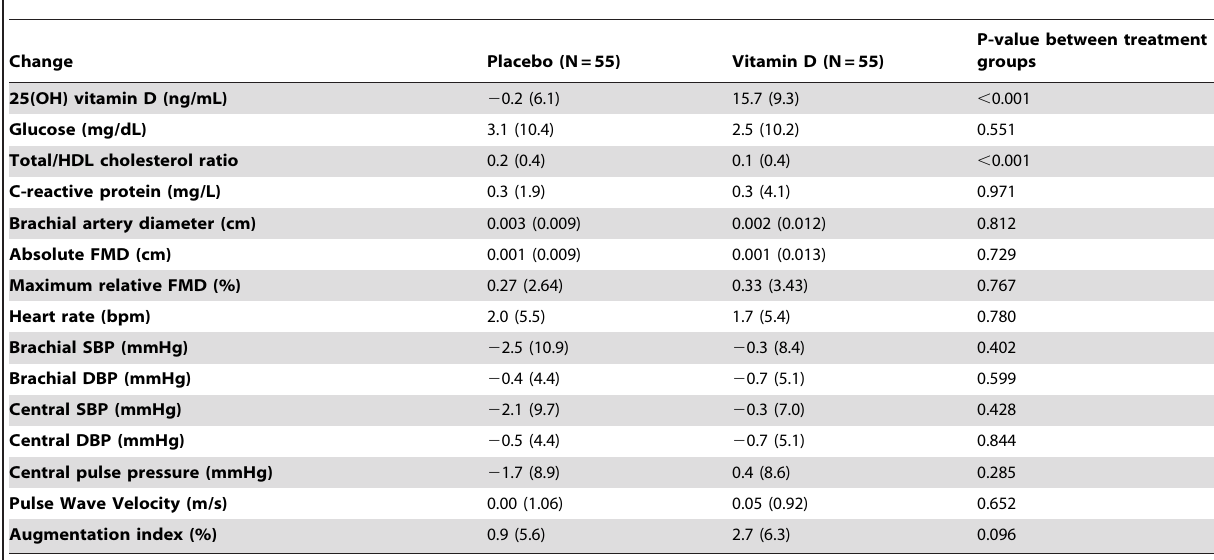
Table 2. Changes from Baseline in Placebo vs. Treatment Groups after 4 Months.